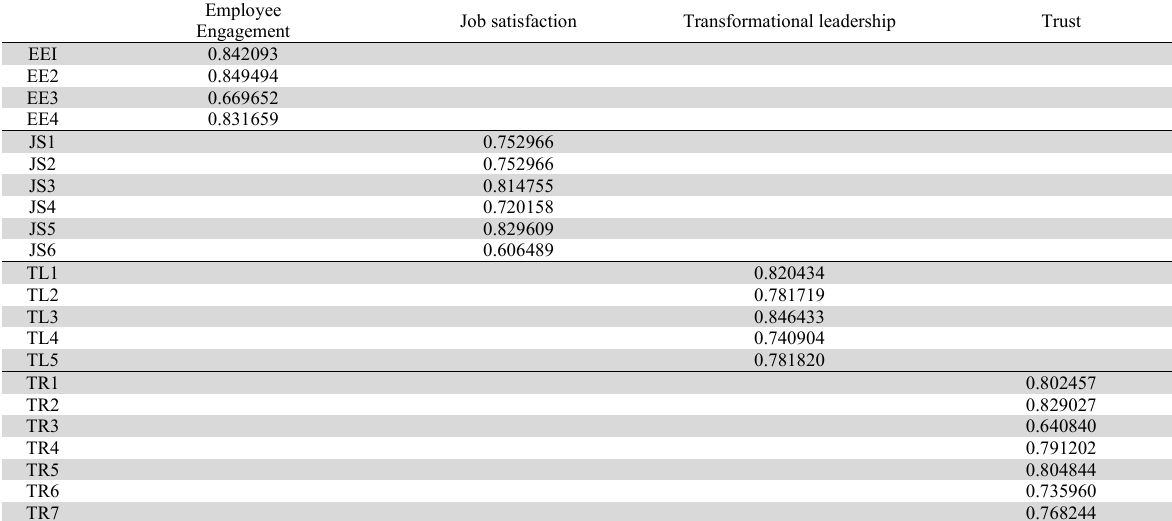
Output Result for Outer Loading Employee Engagement